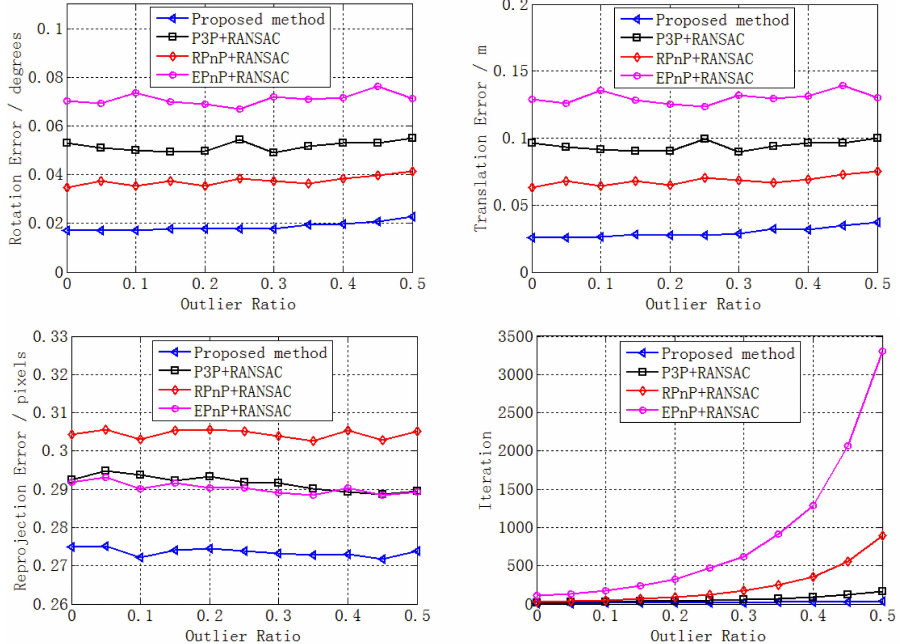
Figure 8. Performance analysis of outlier ratio in terms of rotation error ( top left ), translation error ( top right ), reprojection error ( bottom left ), and number of iterations ( bottom right ) for our proposed method (blue), P3P + RANSAC (black), RPnP + RANSAC (red), and EPnP + RANSAC